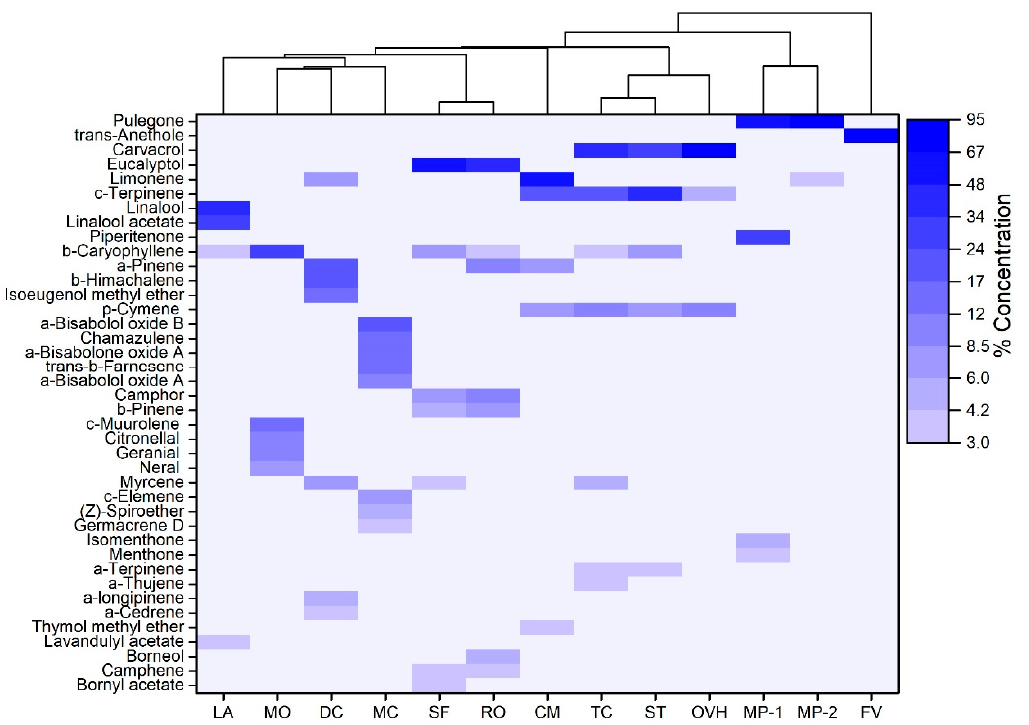
Figure 1. Heatmap and dendrogram of hierarchical cluster analysis for the 13 essential oils under investigation based on the percentage concentrations of their most abundant chemical constituents. (LA = lavender, MO = lemon balm, DC = wild carrot, MC = chamomile, SF = Greek sage, RO = rosemary, CM = rock samphire, TC = Spanish oregano, ST = savoury, OVH = Greek oregano, MP-1 = pennyroyal from Ikaria, MP-2 = pennyroyal from Thessaloniki, FV = fennel).